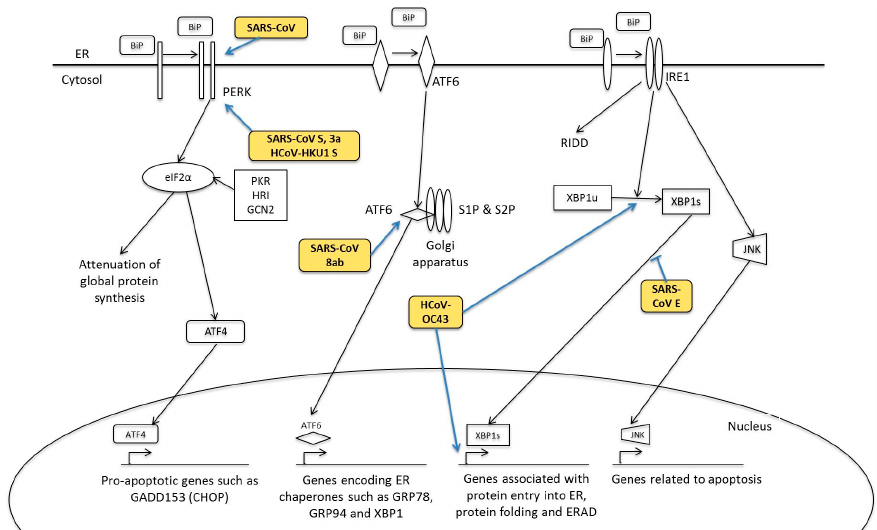
Figure 6. HCoVs on ER stress response. During HCoV infections, the ER stress response, which comprises of three signalling pathways, PERK, ATF6 and IRE1, is activated. HCoVs encode many viral proteins (yellow-orange boxes) that target the various signalling pathway of ER stress during viral infections.